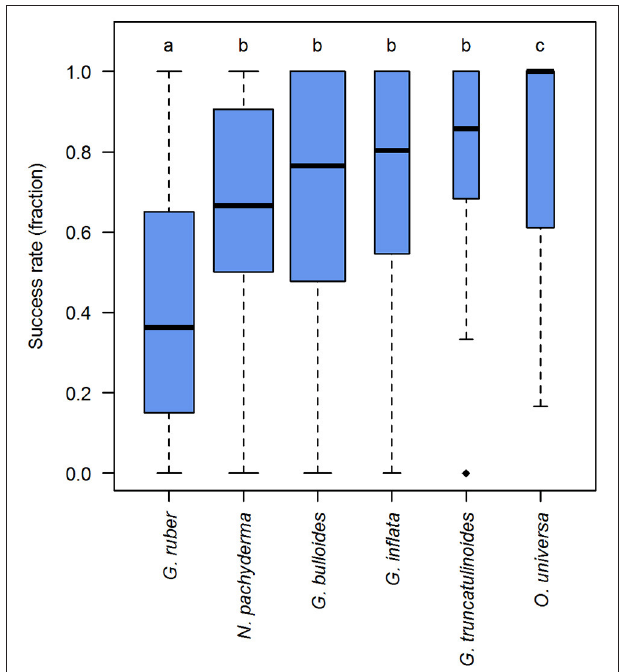
FIGURE 5 | DNA amplification success rates in planktonic foraminifera in dependence of morphospecies identity. Boxplot showing the median (thick black lines), interquartile range (blue boxes), 1.5 × interquartile range (whiskers), and outliers (black diamonds) of the success rates in molecular analysis of planktonic foraminifera. Box widths are scaled to the number of observations within morphospecies. Lower case letters above boxes indicate groups between which success rates differ significantly (compare Supplementary Data Sheet